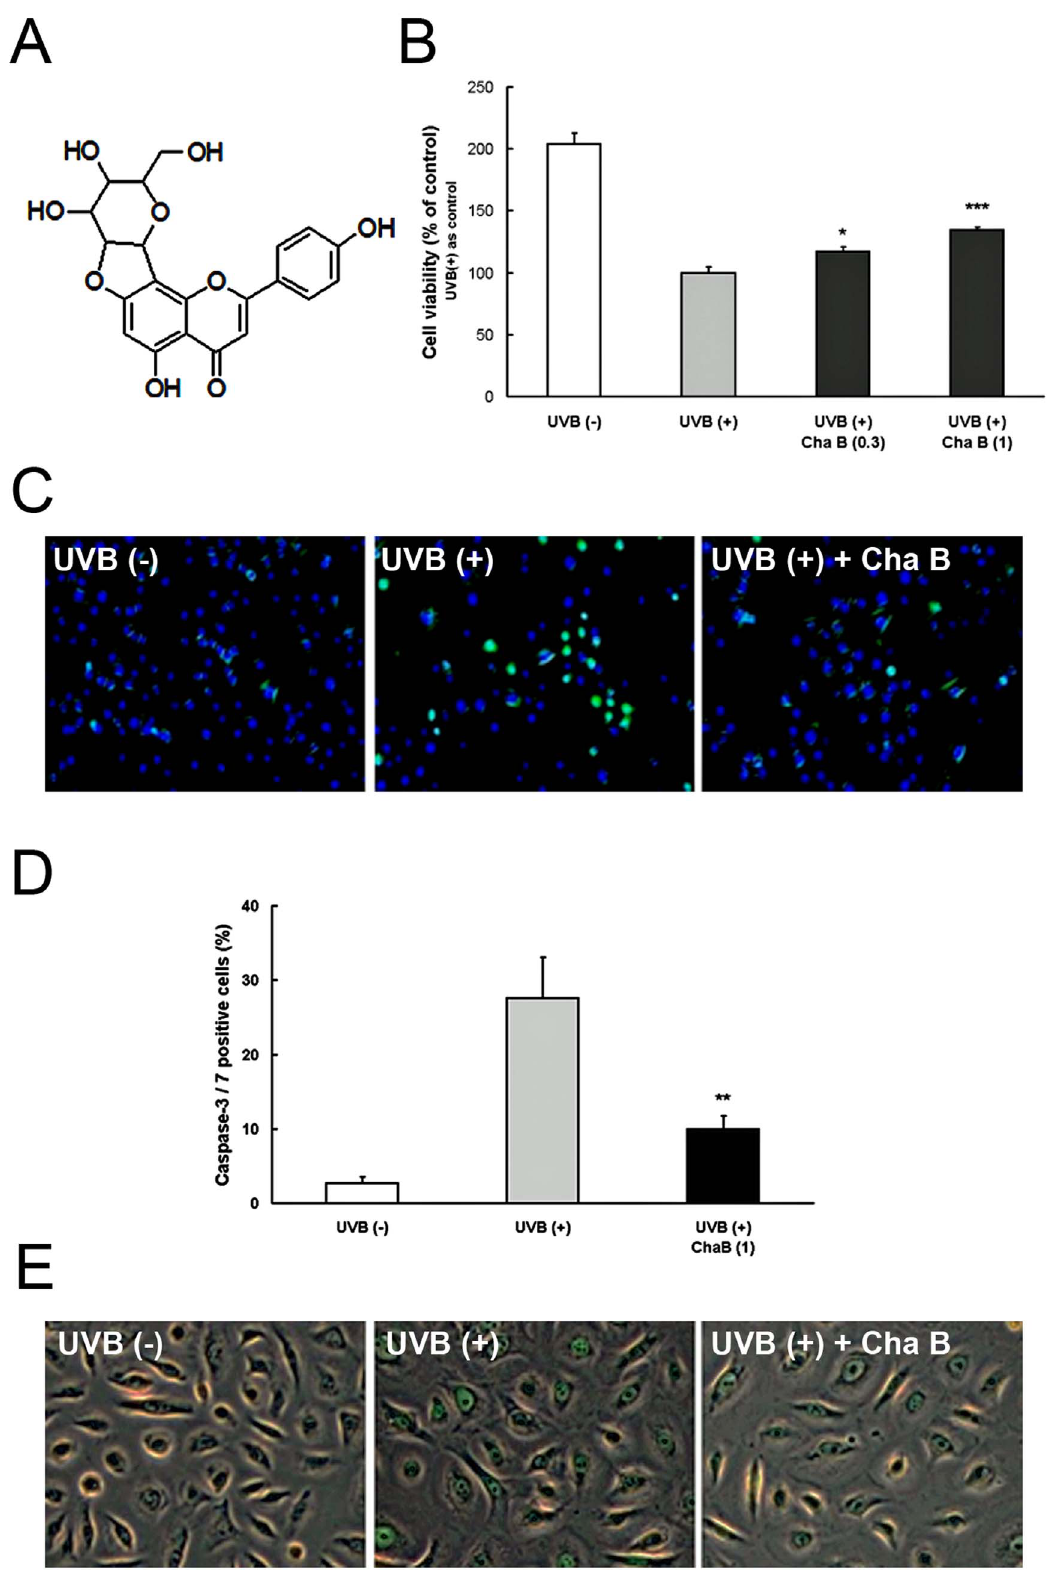
Figure 1. Chafuroside B attenuated DNA damage, cell damage, and apoptosis in UVB-exposed human keratinocytes. A Chemical structure of chafuroside B. B NHEK were irradiated with UVB (20 mJ/cm 2 ), and then treated with chafuroside B (0.3 and 1 m M). Alamar blue assay was used to evaluate cell viability at 48 h after treatment. C, D NHEK were irradiated with UVB (20 mJ/cm 2 ), and then treated with chafuroside B (1 m M). After 6 h, apoptotic cells were detected with CellEvent Caspase-3/7 Green Detection Reagent, which produces bright green fluorescence. Nuclei were